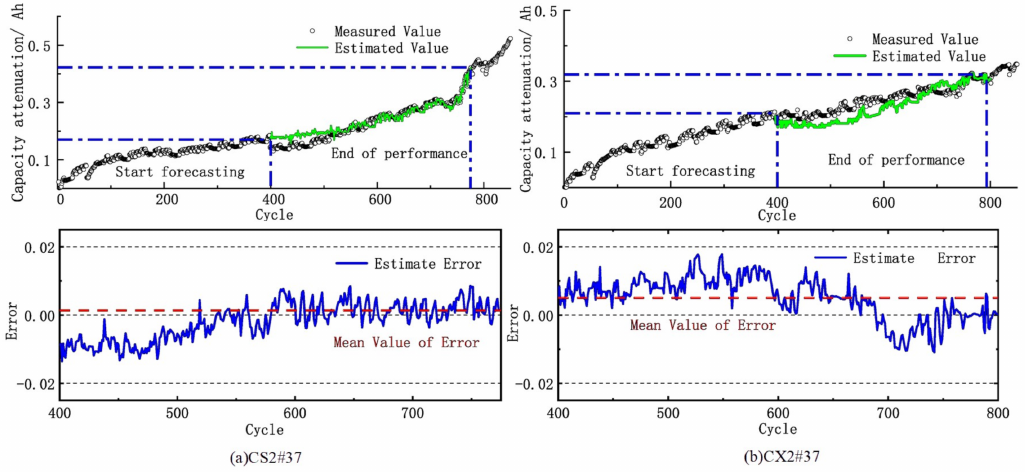
Figure 7. Capacity decay estimates and error for CS2#37 and CX2#37 batteries.